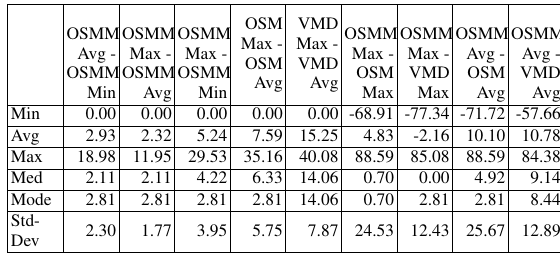
Figure 6: Maximum elevation values for the OSMM dataset - point approximately 0.2m away from building 5.1.3 Variation Across the Datasets Table 3 shows a compar- ison across the different datasets, highlighting the variation both within the different OSMM data and between OSMM, VMD and OSM.